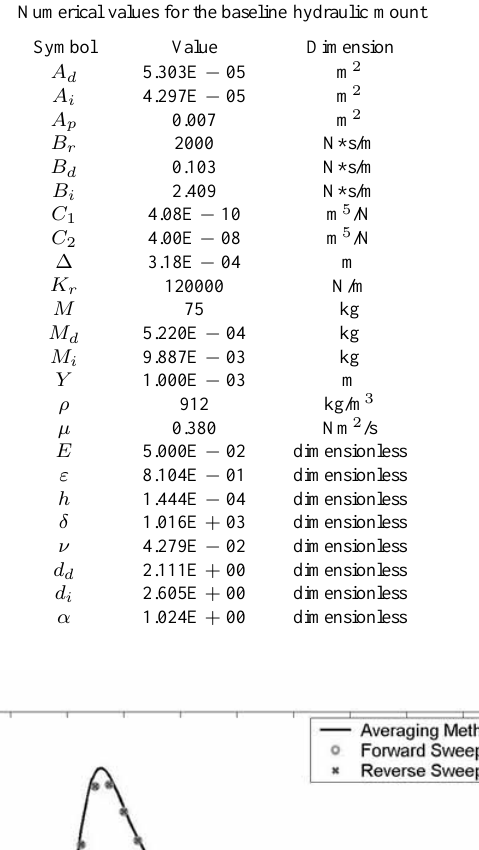
Table 1 Numerical values for the baseline hydraulic mount